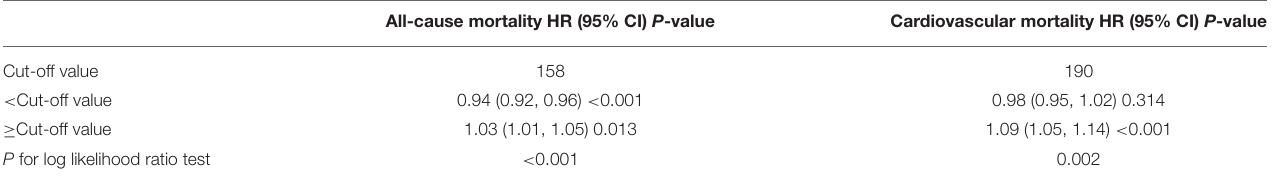
TABLE 3 | The results of two piecewise linear regression model between non-HDL-C and cause-specific mortality. All-cause mortality HR (95% CI) P -value